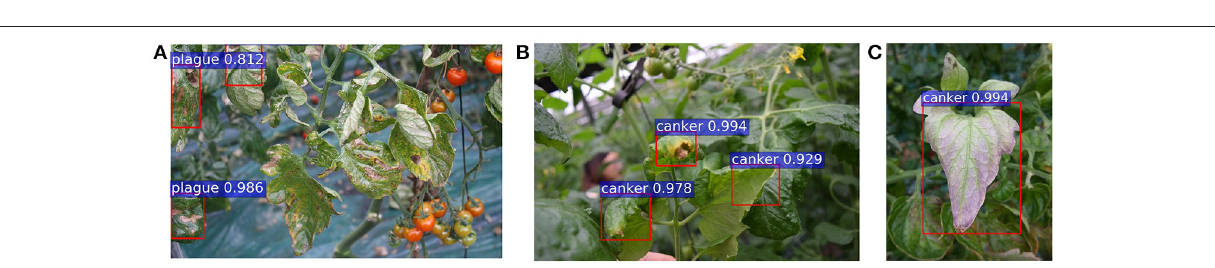
Frontiers in Plant Science |